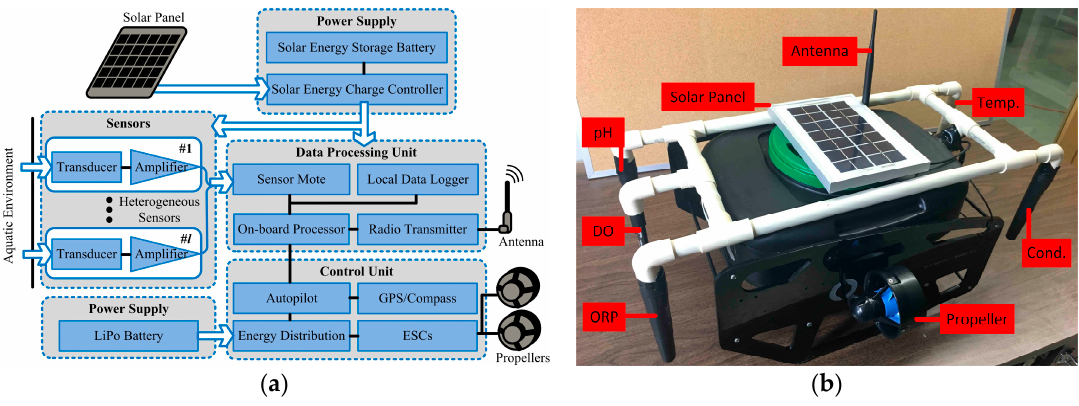
Figure 4. ( a ) The design framework of the Mobile Sensor Nodes (MSN); ( b ) The developed MSN in the IoT platform.